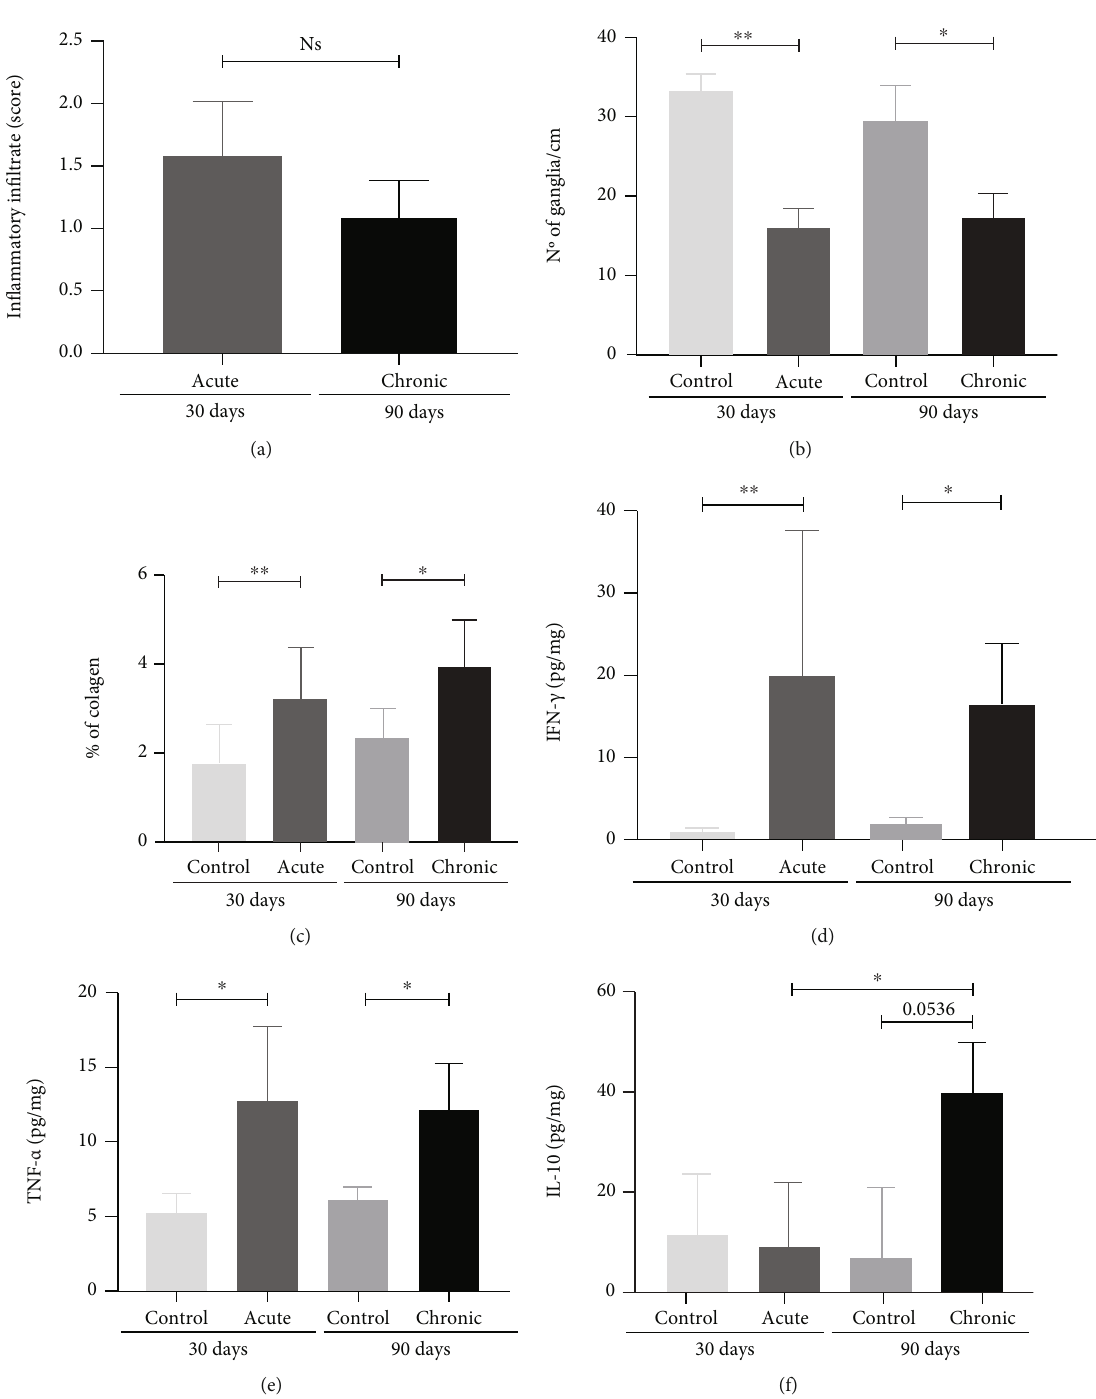
Figure 2: Intestinal immune and histopathological di ff erences between the acute and chronic phases of T. cruzi Colombian strain infected C57Bl/6 mice. (a) Intensity of the intestinal in fl ammatory in fi ltrate. (b) Number of intestinal nerve ganglia. (c) Percentage of intestinal collagen deposition. Quanti fi cation of intestinal levels of (d) IFN- γ , (e) TNF- α , and (f) IL-10. Mann – Whitney test. ∗ Signi fi cant statistical di ff erences at p < 0 : 05